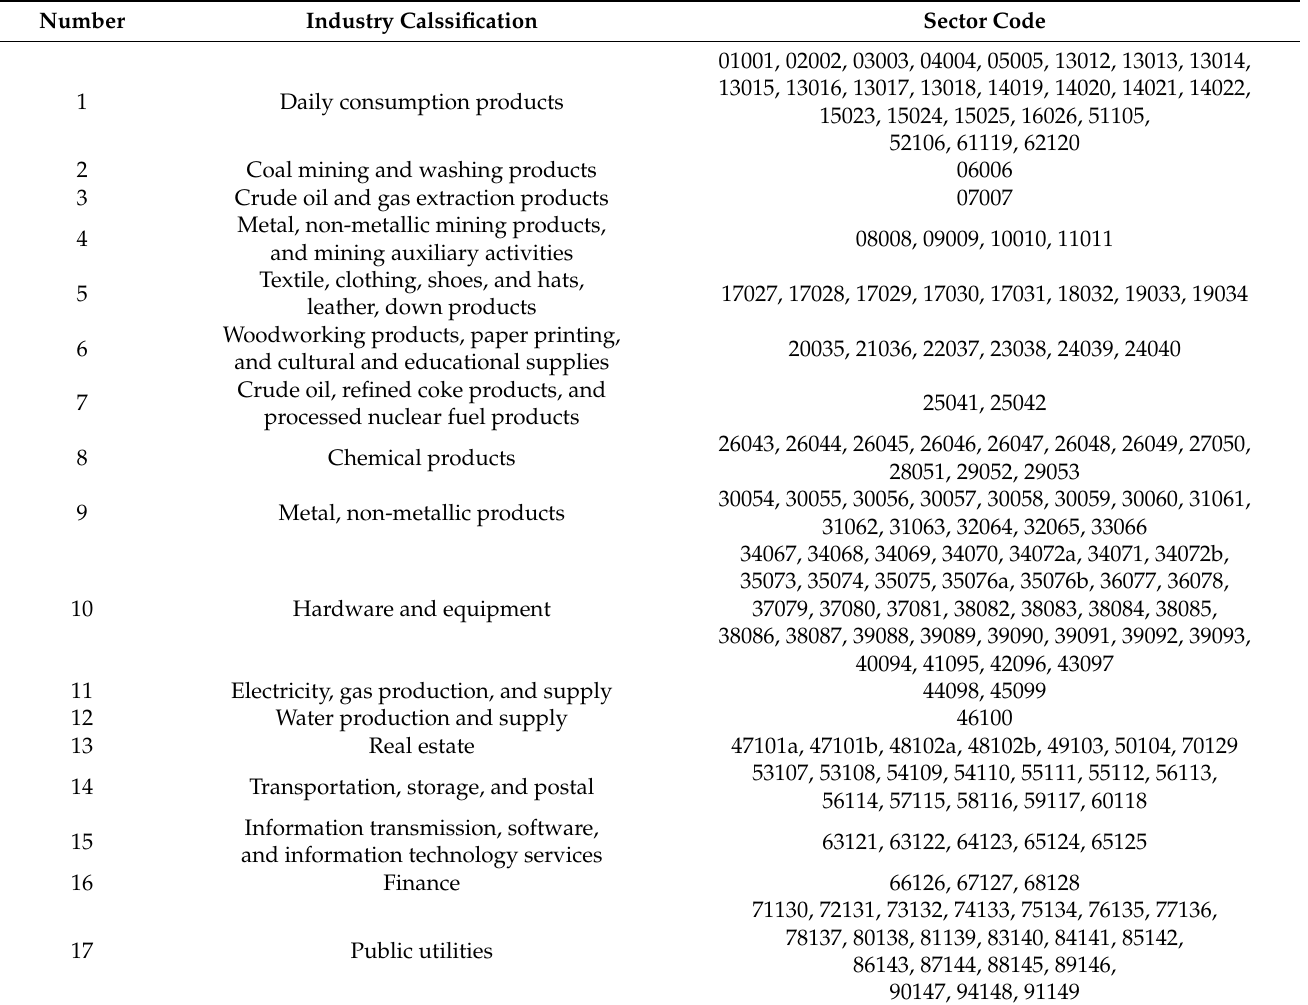
Table A1. Industry Sector Classification.